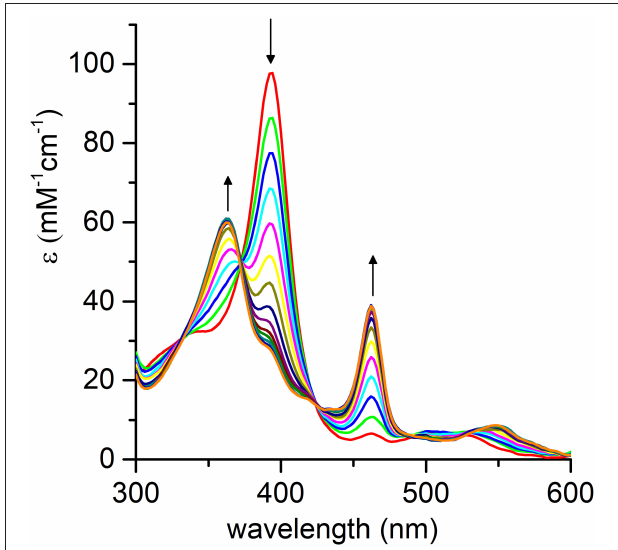
FIGURE 8 | Evolution of the UV-vis absorption spectrum of [Mn IV = O] ·+ upon addition of thioanisole (100 eq.); arrows indicate the direction of absorbance variations. Reaction conditions : Mn-MC6*a, 20 µ M; H 2 O 2 , 2.0mM; thioanisole 2.0mM; 60mM carbonate buffer with 40% TFE ( v/v ), pH 9.5; T = 25 ◦